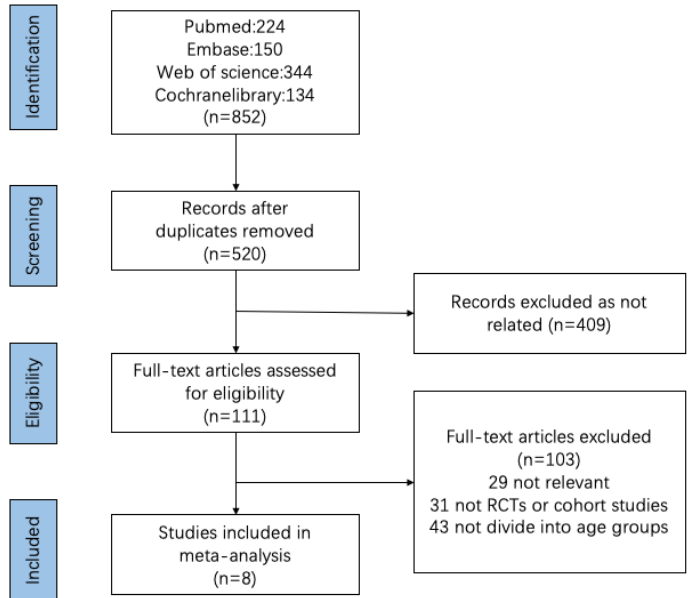
Figure 1. Flowchart of studies evaluating qualified research through selection process.